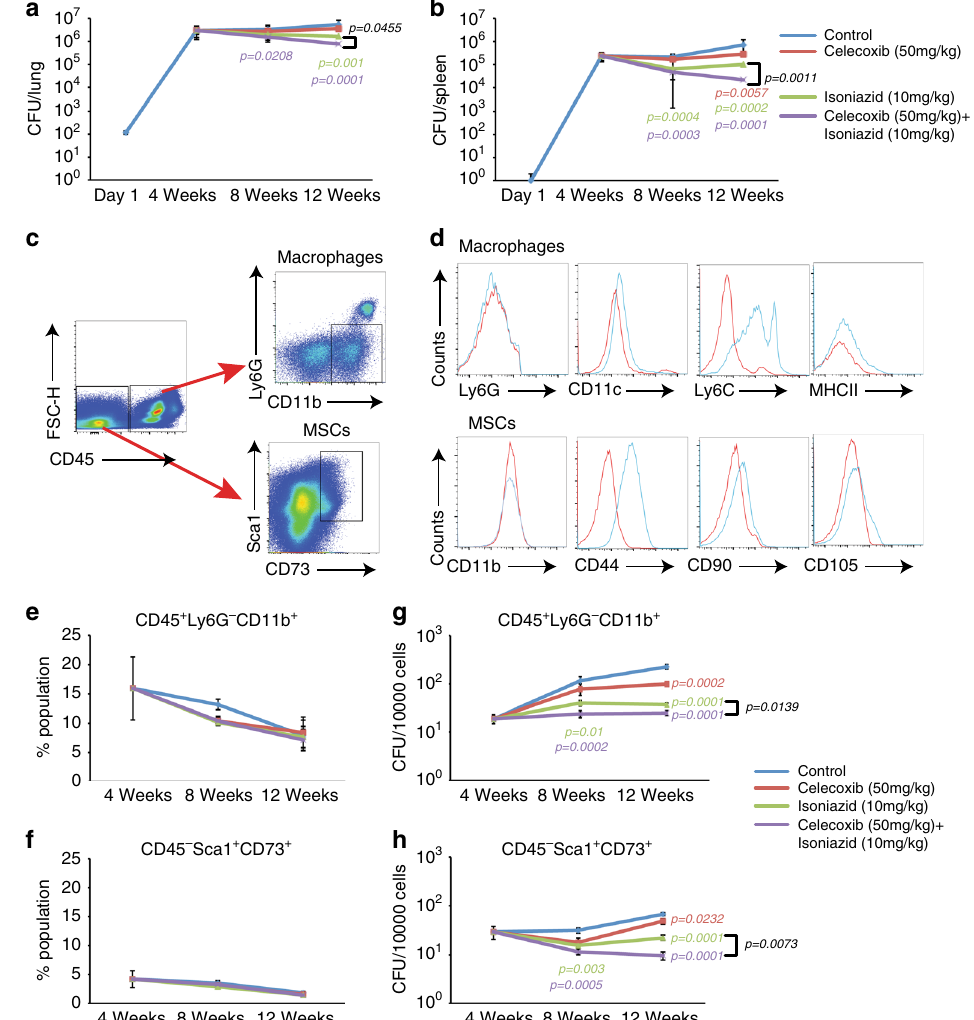
Fig. 4 PGE2 facilitates Mtb survival within lung MSCs in vivo. a Total bacterial CFU in the lungs of C57BL/6 mice infected with H37Rv via aerosol route (~10 2 bacilli/lung) administered with vehicle, celecoxib (50 mg/kg), INH (10 mg/kg), or combination of celecoxib with INH (50 mg/kg and 10 mg/kg, respectively). Treatments started 4 weeks post infection and were given every day for next 8 weeks. b Total bacterial CFU from the spleen of infected animals during the course of experiment mentioned above ( c ) Gating strategy for sorting of MSCs and monocyte/macrophages from mice lung. Live singlet population was gated for CD45 positive and negative population which were sub-gated based on Ly6G − CD11b + for macrophages or myeloid cells and Sca1 + CD73 + for MSCs, respectively. d Characterization of the gated macrophage and MSC population with additional cell speci fi c surface marker. Upper panel is for CD11b + macrophage stained for Ly6G, CD11c, Ly6C, and MHCII. Lower panel is for CD73 + MSCs stained with CD11b, CD44, CD90, and CD105. e – f Change in lung tissue landscape comprising macrophages (CD45 + Ly6G − CD11b + ) and MSCs across 12 weeks of infection and upon treatment with celecoxib, INH or celecoxib + INH. g – h Mtb survival within sorted macrophages (CD45 + Ly6G − CD11b + ) and MSCs (CD45 − Sca1 + CD73 + ) along the course of infection and treatment as discussed above. All above data are represented as mean ± SD, n = 3 independent experiments (total ten mice). Statistical analysis was done Mann − Whitney U test. Source data are included in the source data fi (Fig. 4g, h). The number of bacilli in both cells progressively increased from week 4 to week 12, shown as the number of bacilli per 10,000 cells (Fig. 4g, h). The macrophage-resident Mtb were not affected by celecoxib at 4 weeks of treatment however showed a signi fi cant decline at 8 weeks post treatment (Fig. 4g). Similarly,